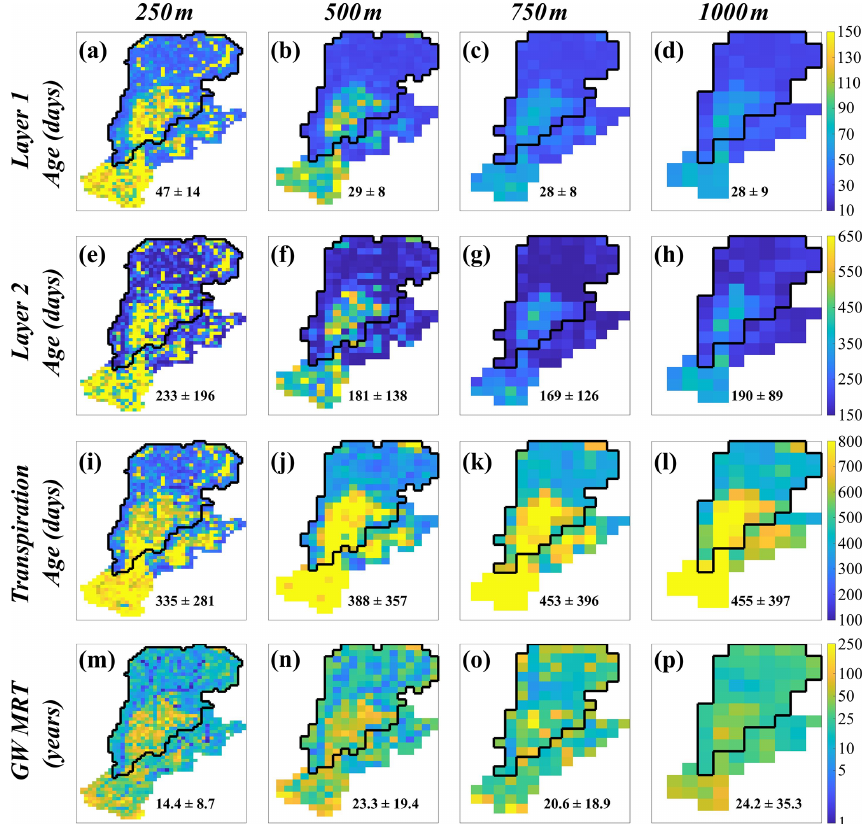
Figure 7. Estimated average water ages during the summer (June–August) in (a–d) soil layer 1 and (e–h) layer 2 and (i–l) transpiration and (m–p) long-term groundwater mean residence time (GW MRT) for model resolutions 250, 500, 750, and 1000m, respectively. Note: groundwater residence times are in years. Black boundaries show the calibration extent of the Demnitz Mill subcatchment. Values shown are the catchment-wide, long-term (2009–2019) average values and average standard deviation (average of each pixel) within the Demnitz Mill